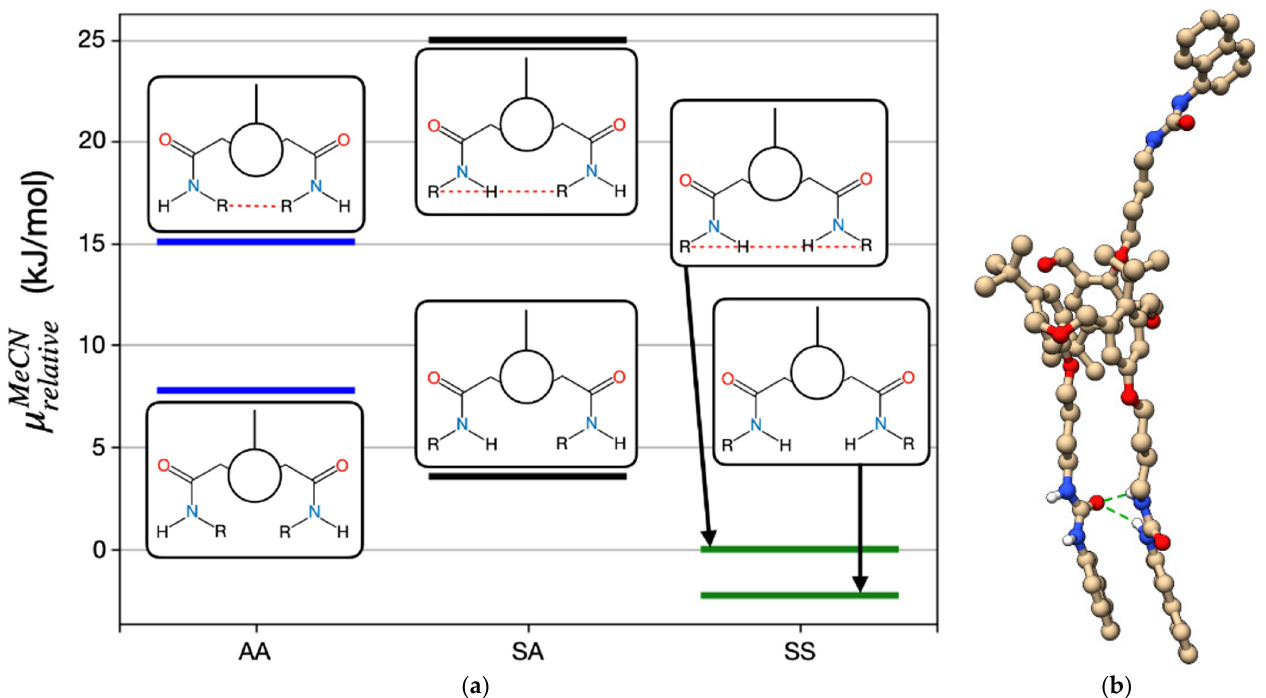
Figure 8. ( a ) Relative chemical potentials of 4a arm main conformers in MeCN (as a continuum dielectric) at 300 K. Dashed lines denote π -stacking interactions of the naphthyl groups; ( b ) optimised structure for the SS’ conformer. Intramolecular hydrogen bonds are represented by green dashed lines.